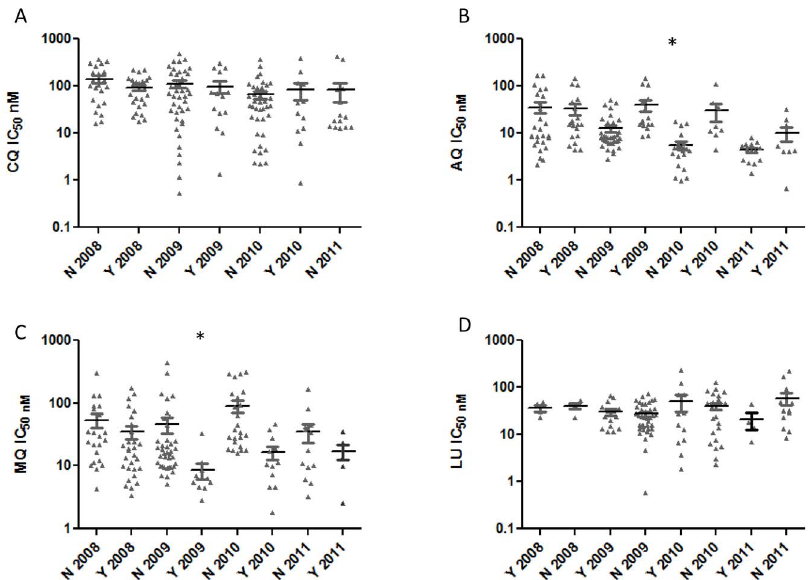
Figure 2. Pfmdr1 N86Y SNP compared against drug IC 50 s (in nM). A. Comparison of Pfmdr1 N86Y SNP against CQ IC 50 stratified by year; B. Comparison of Pfmdr1 N86Y SNP against AQ IC 50 stratified by year; C. Comparison of Pfmdr1 N86Y SNP against MQ IC 50 stratified by year; D.